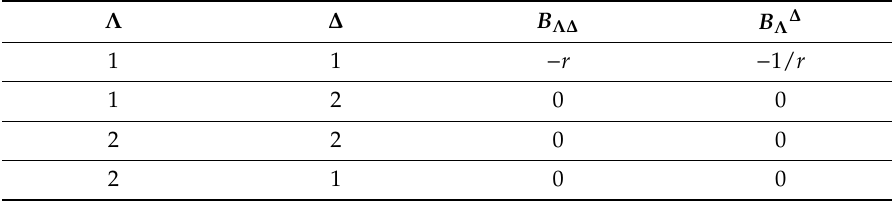
Table A1. Curvature tensors for a cylinder of radius r